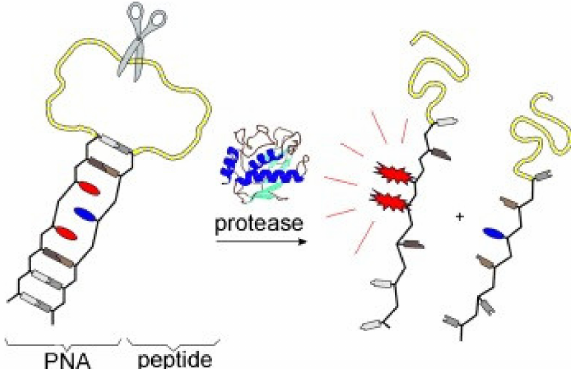
Figure 2. Chemical structures of fluorophore 1 and quencher anthraquinone.